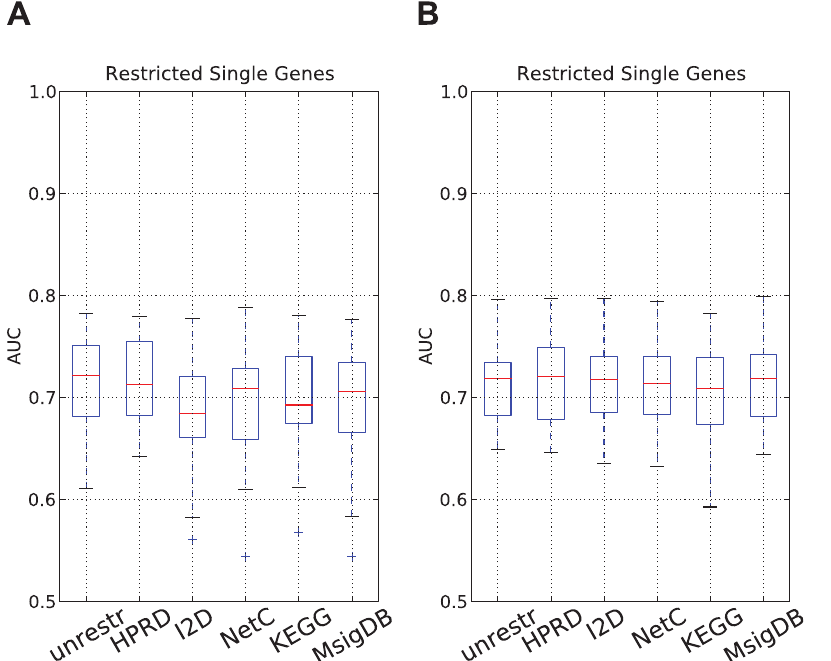
Figure 4. Comparison of single genes classifiers restricted to genes occurring in the secondary data sources. We compared the performance of the single genes classifier trained on all genes present on the microarray ( unrestr. ) with the performance of single genes classifiers that only employ genes present in the secondary data sources. The resulting classifiers are indicated by the secondary data source whose gene set was employed to train the classifier. A: The number of single genes was determined during the cross-validation procedure; B: the 50 best scoring single genes were employed.